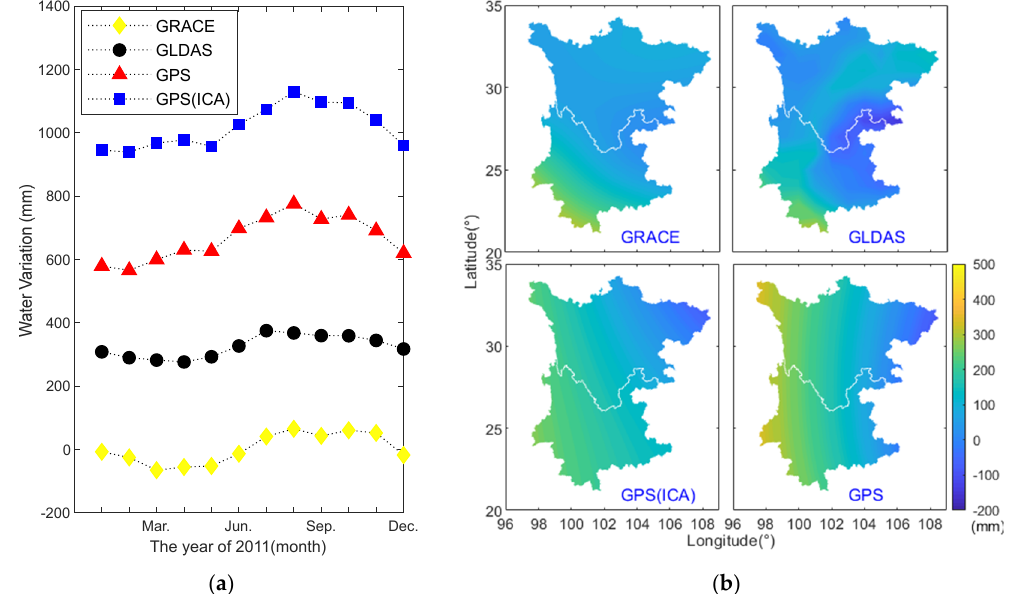
Figure 9. Monthly variations (2011) of the TWS in Sichuan-Yunnan estimated by GLDAS.